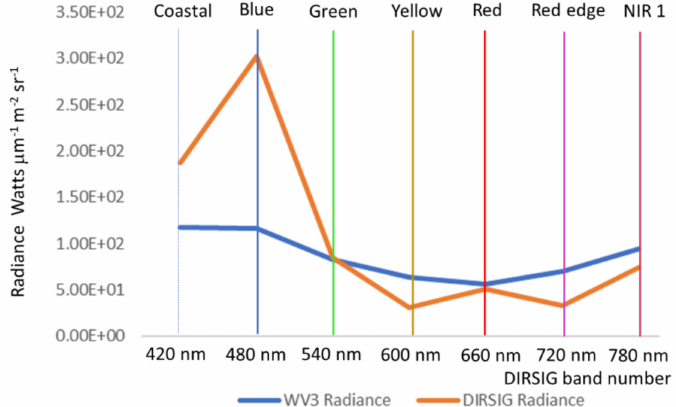
Figure 6. WorldView-3 radiance vs. DIRSIG simulated radiance (Watts µ m − 1 m − 2 sr − 1 ) for a blue tarp placed on the SGP site during image collection. The horizontal axis represents the spectral bands in the WorldView-3 images and DIRSIG simulations. The vertical axis represents the average intensity of the pixels sampled on the tarp, for both the simulation (orange curve) and WorldView-3 (blue